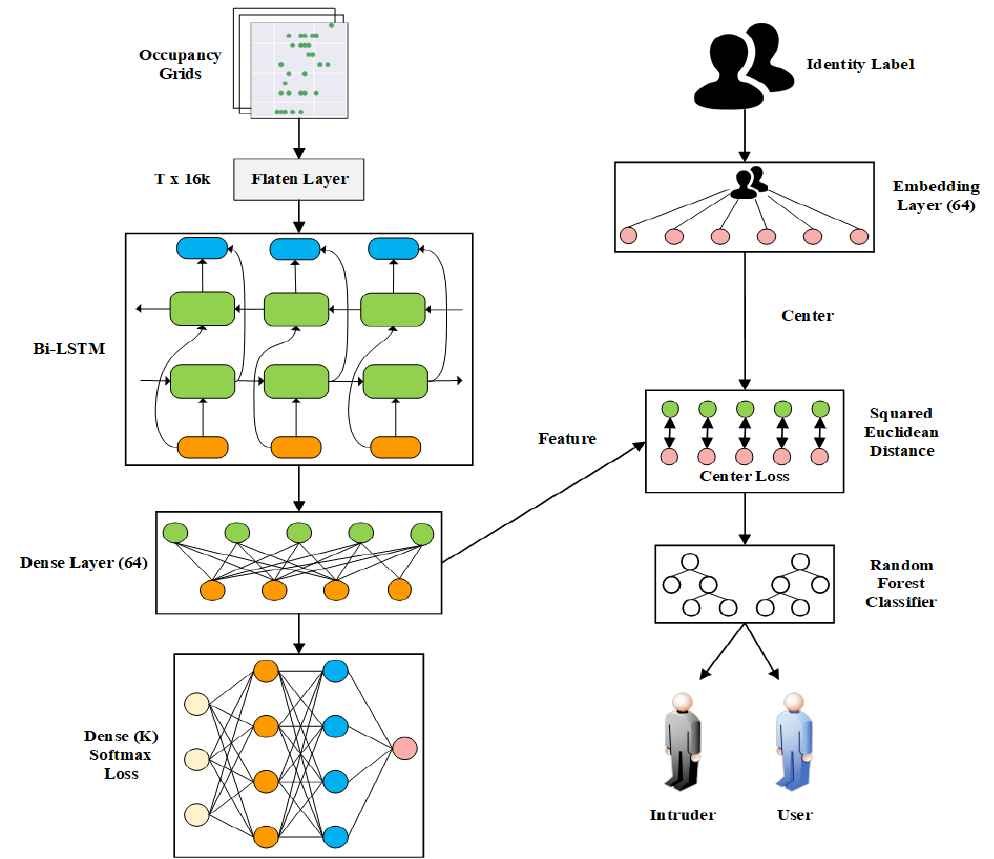
Figure 4. Classification Network